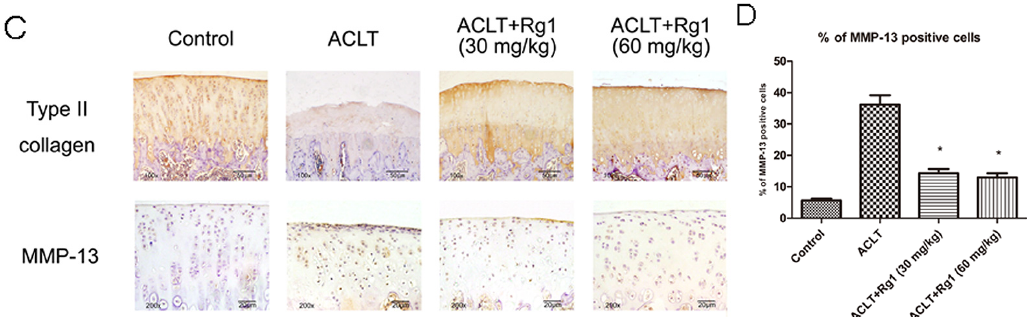
Figure 4. Histological and immunohistochemical findings. Four weeks after ACLT, Rg1 intervention groups received Rg1 (30 or 60 mg/kg/day) by gavage once daily for eight consecutive weeks. ( A ) representative photomicrographs of hematoxylin and eosin (H&E), Safranin O ‐ fast green, and toluidine blue ‐ stained tissue sections of knee joint specimens from OA rats treated with Rg1 or saline (original magnification ×100); ( B ) joint lesions were graded on a scale of 0–13 using the modified Mankin scoring. They were graphed as dot plots with the mean (bar) of 12 rats per group; ( C ) representative photomicrographs of immunohistochemical staining for type II collagen (original magnification ×100) and MMP ‐ 13 (original magnification ×200). Yellow staining indicates collagen type II expression in the cartilage. MMP ‐ 13 positive cells are stained brown; and ( D ) bar graphs represent mean percentage ± SEM of MMP ‐ 13 ‐ positive cells in 12 rats per group. * p < 0.05 compared with the ACLT group.